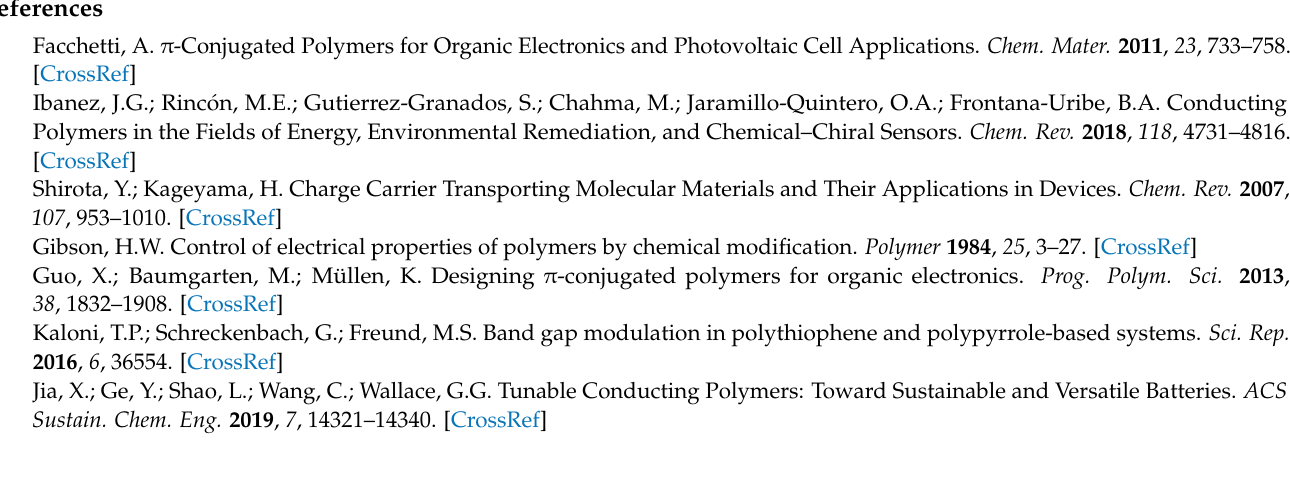
Figure S8: IR spectra of (a) 5 and (b) PTPA, Figure S9: SEC traces of PTPA (THF, 36 ◦ C, 0.6 mL/min). Estimated molecular weight was Mn = 22,200 and Mw = 303,400. Figure S10: XPS spectrum of PTPA. Figure S11: SEM images and element mapping images of PTPA